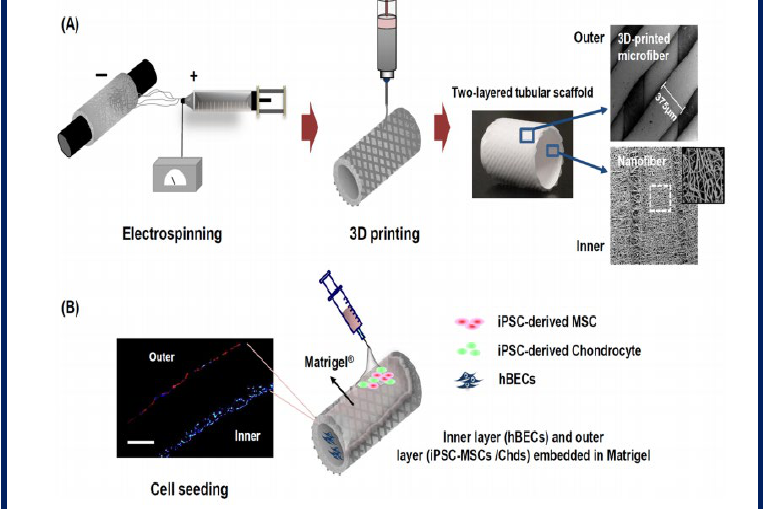
Figure 22. Illustrative schematic of the fabrication of three-dimensional tubular artificial tracheal scaffolds ( A ): The inner layer was fabricated from electrospun polycaprolactone (PCL) nanofibers and the outer layer from 3D-printed PCL strands. ( B ): Scaffolds were seeded with induced pluripotent stem cell-derived chondrocytes (iPSC-Chds in the outer layer and human bronchial epithelial cells (hBEC) in the inner layer of the scaffold. Identification was by PKH-26 staining (red color; iPSC-chds) and DAPI staining (blue color; hBEC). Bibliography consulted [31] is licensed under CC BY 2.0. To view a copy of this license, visit http://creativecommons.org/licenses/by/4.0/ (accessed on 15 December 2022).